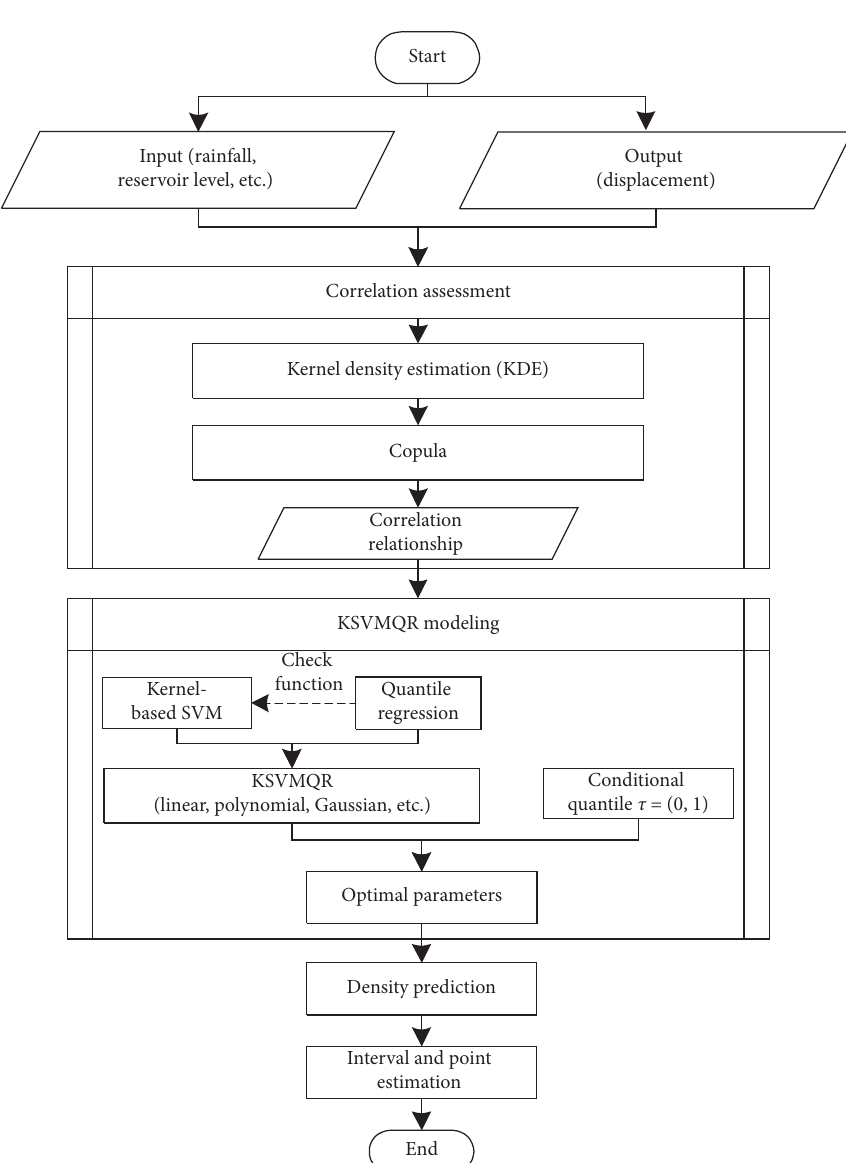
Figure 3: The overall framework of the density prediction for landslide displacement using the copula-KSVMQR approach.